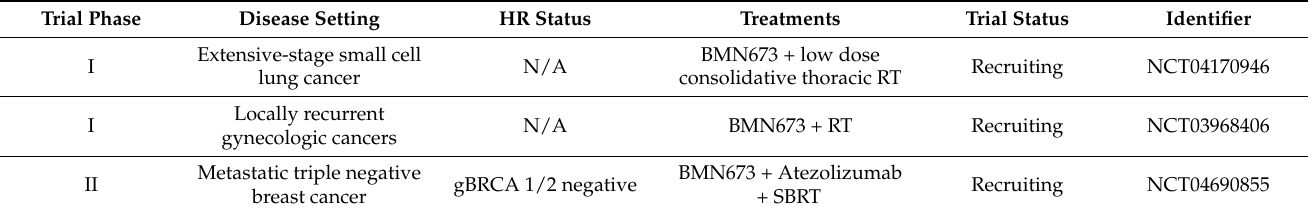
Table 2. Registered clinical studies of BMN673 in combination with